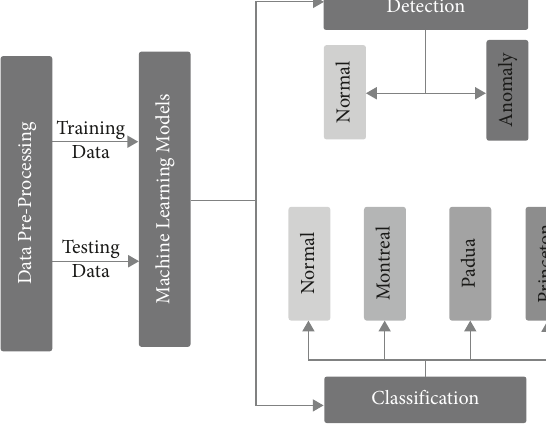
Figure 1: ML-based bitcoin transaction predictive